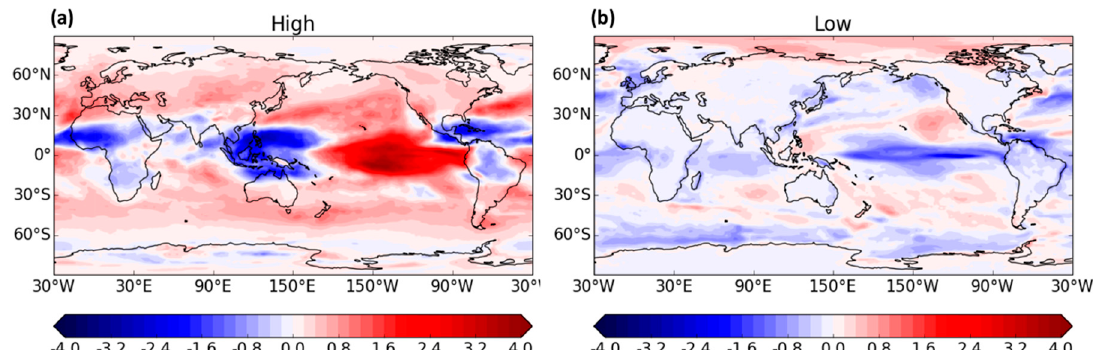
Figure 8. Geographical distributions of cloud feedback (% K − 1 ) for ( a ) high-level cloud and ( b ) low-level cloud in the abrupt experiments for K-ACE. Shadings denote the change in mean cloud area (%) as a function of mean surface air temperature (K) over 150 years in abrupt experiment.